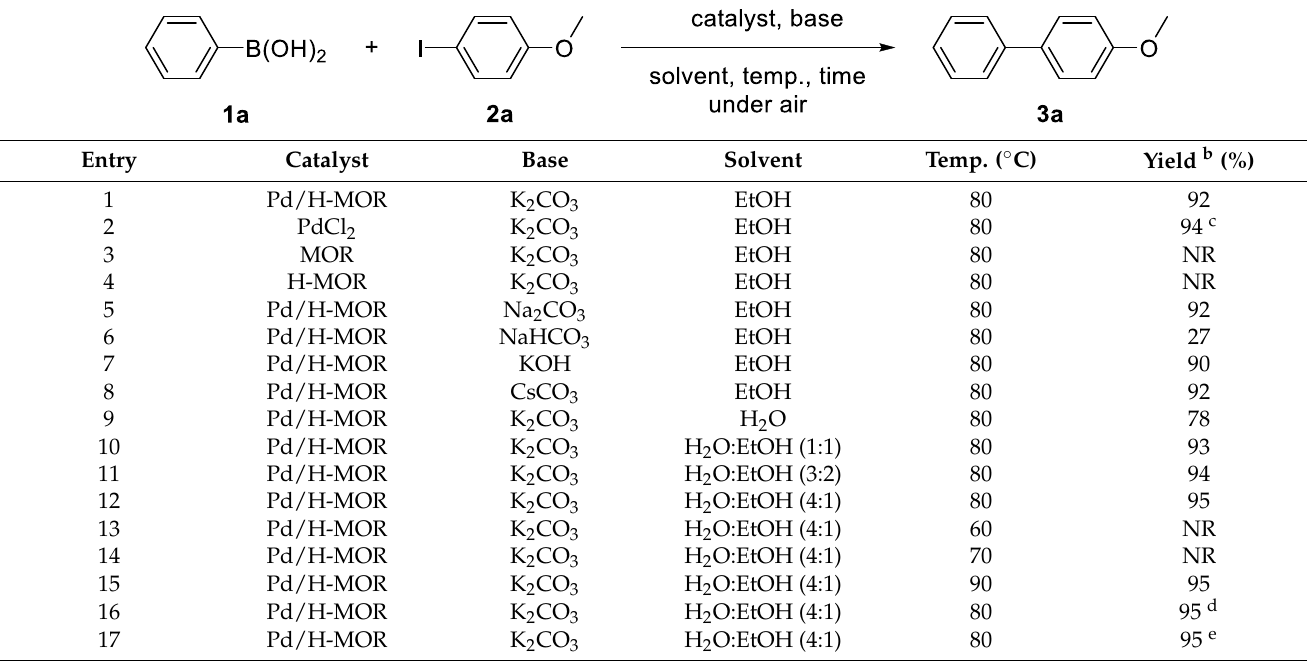
Table 1. Optimization of reaction conditions. a.